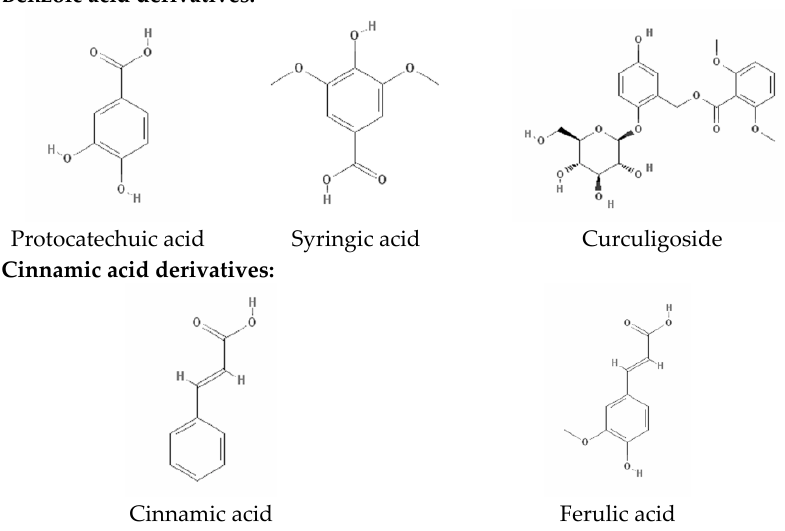
Figure 2. Chemical structures of the identified phenolic compounds [19].